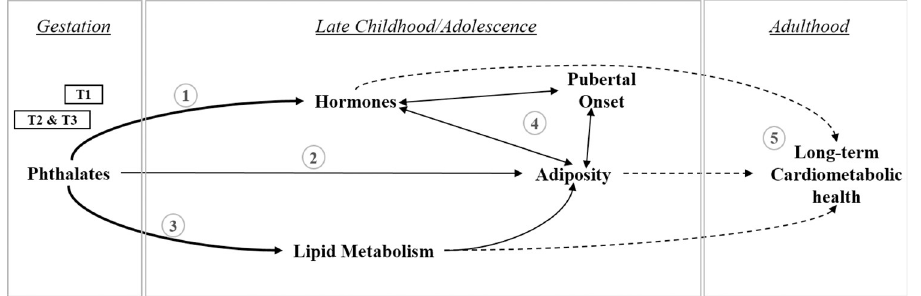
Fig 3. Schematic of the relationship between gestational phthalate exposures, childhood outcomes, and long-term health. Phthalate exposures during pregnancy have been associated with multiple biological responses in children that may underlie risk for cardiometabolic diseases later in adulthood. The graph below highlights connections with evidence from association studies including this study (thick arrows), other published studies (thin arrows), and hypothesized relationships (dashed-line arrows). T1 phthalate exposures, before sexual dimorphism, may influence all children; sex-specific associations with metabolomics were reported with exposures from T2 and T3. In summary, 1) previous ELEMENT studies and the current study identified associations between prenatal phthalate exposures and steroid hormone concentrations in peripuberty. 2) Previous studies reported sex-specific associations between prenatal phthalate exposures and adiposity in children/adolescents. 3) In this study, we identified relationships between prenatal phthalate exposures and metabolites including those involved in lipid metabolism and transport. 4) The pubertal transition is a time of rapid change when hormone levels, adiposity, pubertal onset, and metabolism all influence one another. 5) We hypothesize that these biological changes in childhood, including to the metabolome, are on the path leading to cardiometabolic risk from early-life phthalate